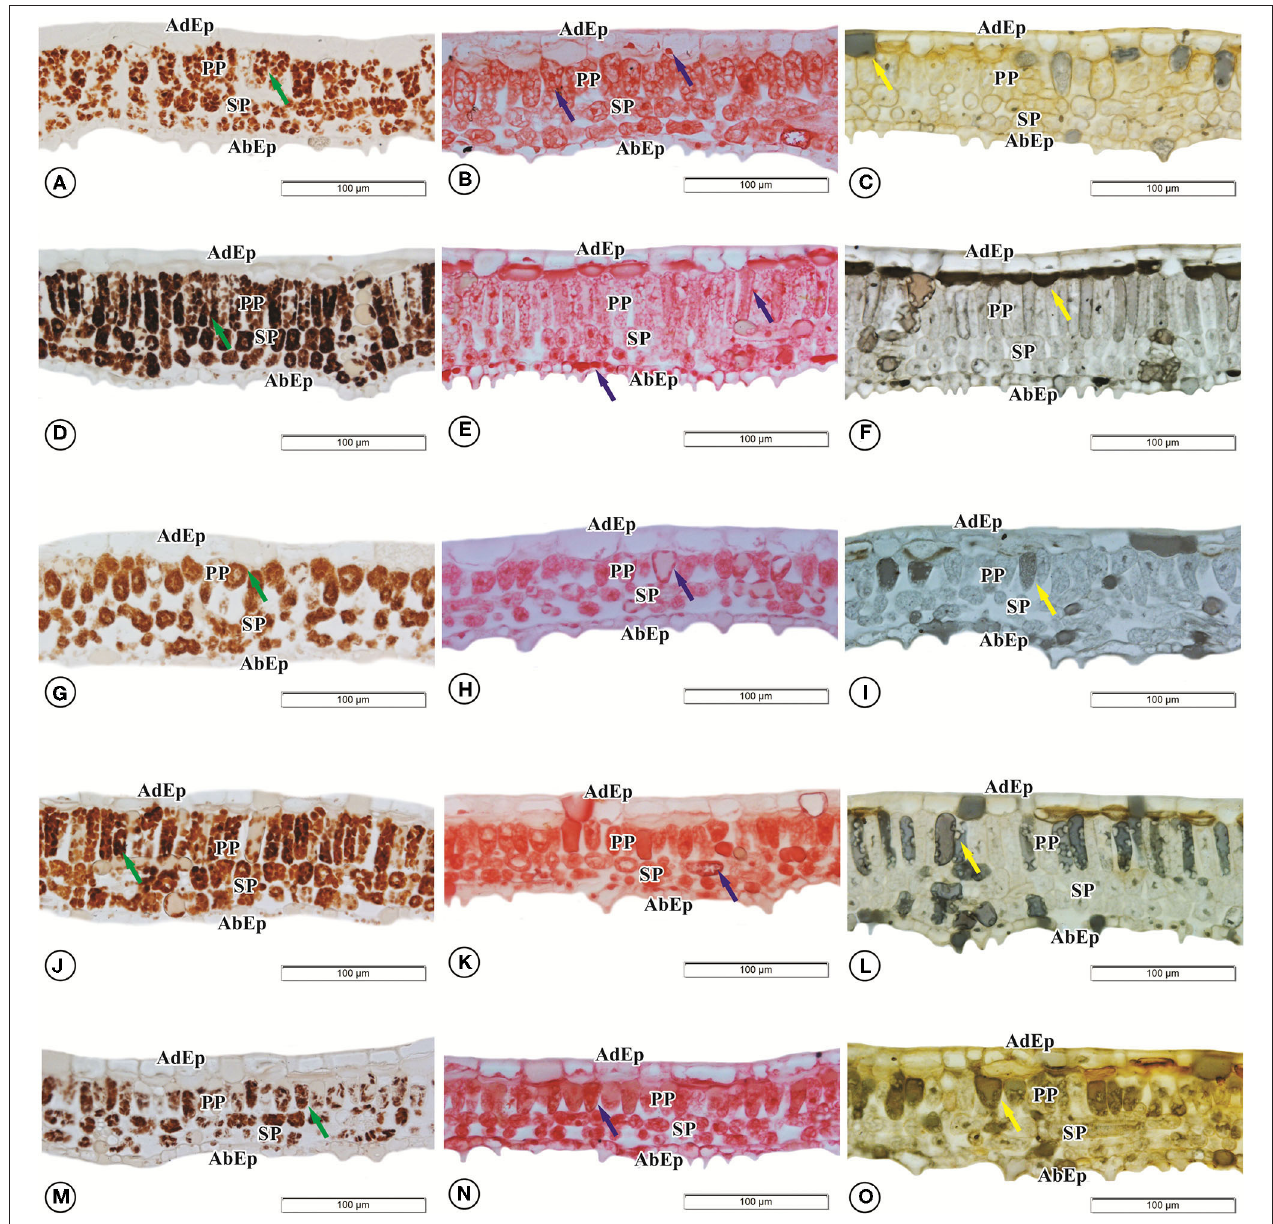
FIGURE 6 | Accumulation of starch (A,D,G,J,M) , protein (B,E,H,K,N) , and phenolic compounds (C,F,I,L,O) in Brosimum gaudichaudii leaves cultivated in vitro under different spectra of LEDs for 50 days: (A–C) white, (D–F) blue, (G–I) red, (J–L) B/R 1:1, and (M–O) B/R 3:1. The green arrows indicate the presence of starch. Blue arrows indicate the presence of proteins. Yellow arrows indicate the presence of phenolic compounds. Scale bar = 100 µ m.